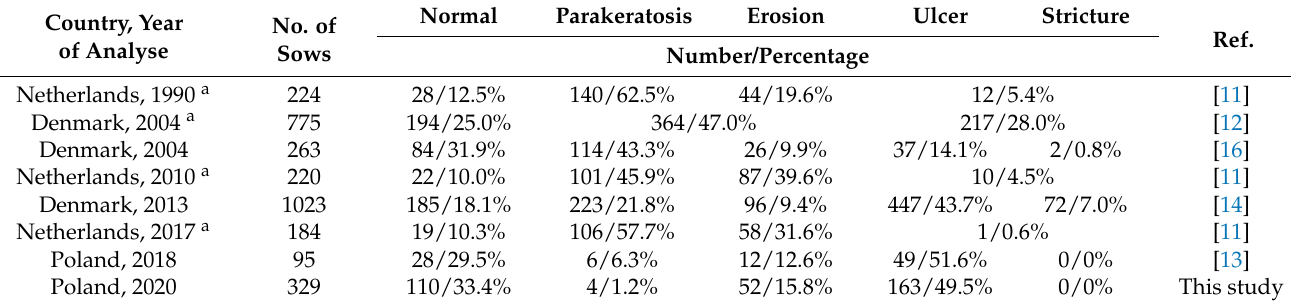
Table 1. The occurrence of macroscopical lesions of the pars oesophagea in sows sampled in this study and in the previous reports from Denmark and the